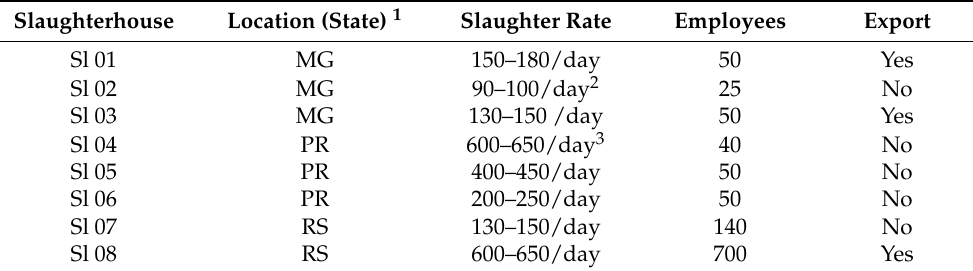
Table 1. Characteristics of the selected Brazilian